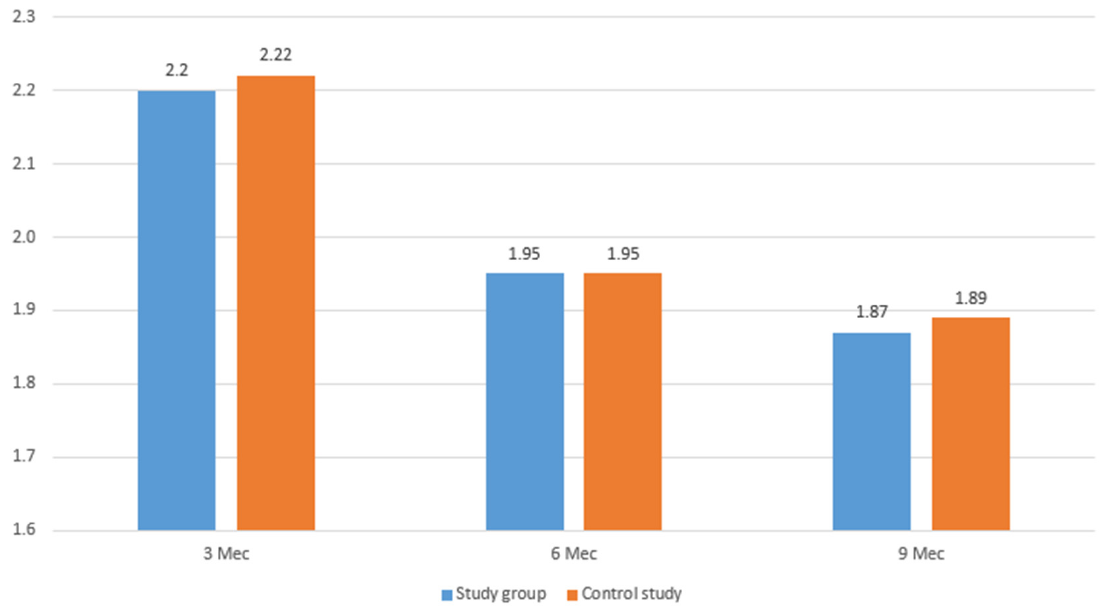
Figure 6. Average group values of the VAS indicator (points).